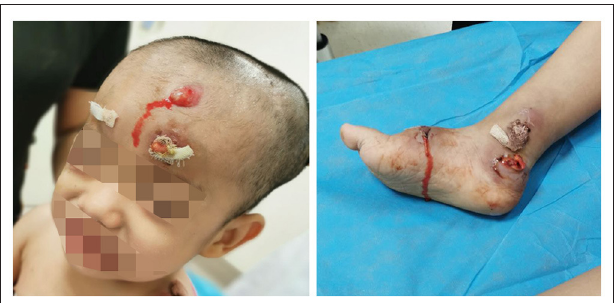
FIGURE 2 | Lumps and purulent secreta due to Mycobacterium intracellulare infection.